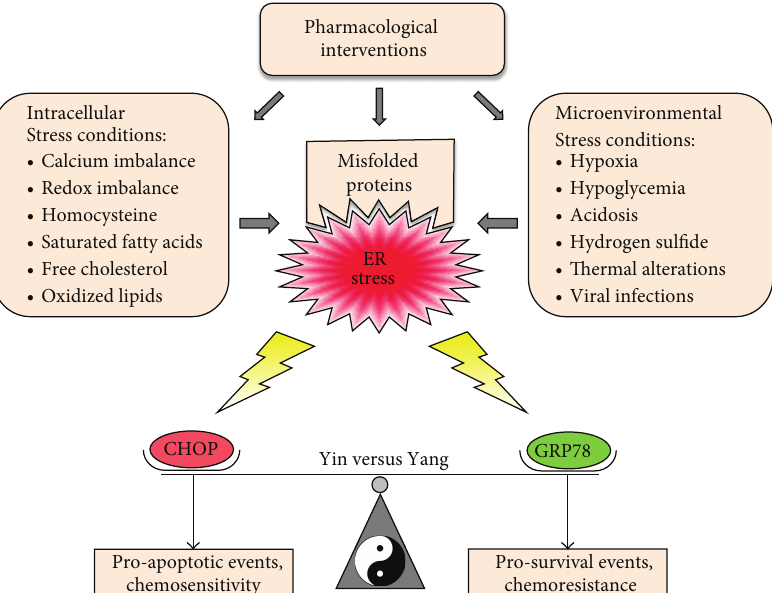
F 1: Triggers of ER stress and the yin-yang balance of cell survival versus cell death. A great variety of conditions and pharmacological compounds can disturb ER homeostasis, leading to ER stress and the accumulation of unfolded and misfolded proteins. In response, ER stress signaling pathways stimulate pro-survival efforts to either neutralize the stressful insult or adapt to it. GRP78 plays a key role in the cell’s attempt to adapt and survive. In contrast, if ER stress is too severe, the pro-apoptotic module of this cellular system gains dominance and shis the balance towards cell death. CHOP represents a central executor of this latter process. In essence, these opposing processes of cell death versus survival are re�ective of the yin-yang (shadow and light) concept of Chinese philosophy, where seemingly contrary forces are interconnected and interdependent as part of a greater whole. Although many other components participate in balancing the cell’s yin-yang response to ER stress, the opposing efforts of prosurvival ( yang ) GRP78 and proapoptotic ( yin ) CHOP represent important tenets of this struggle; as well, their expression levels are being used as convenient markers and readouts as to the ER stress status of cells. Details of GRP78 and CHOP functions are presented in Figures 2 and 3,